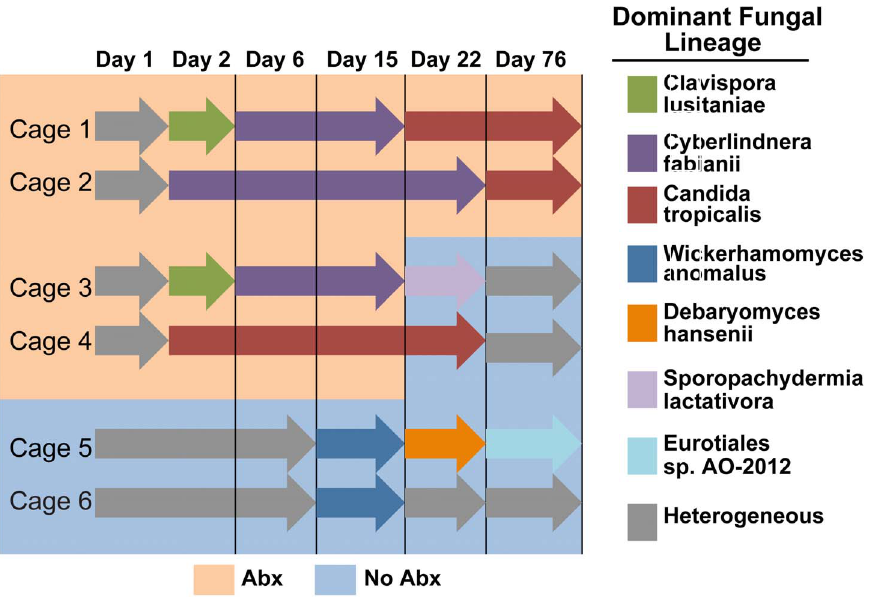
Figure 8. Longitudinal variation in fungal abundance in the six cages studied. Each cage is shown as a row labeled at left, the types of fungi detected are shown at the right. The background shading indicates the presence or absence of antibiotics (key at bottom).